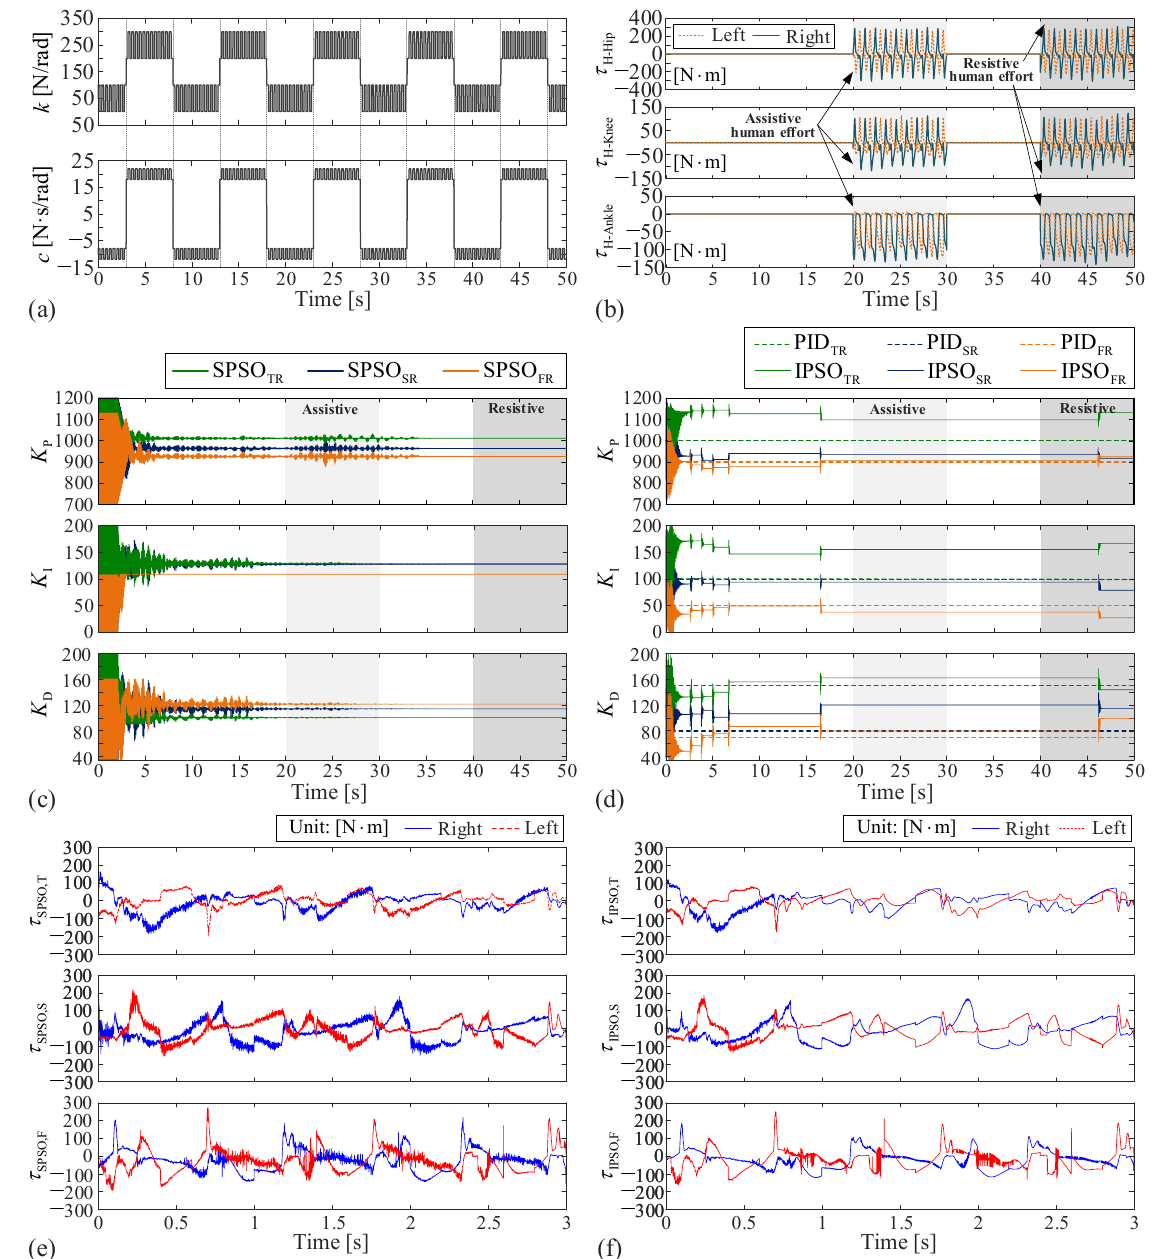
Figure 3. Tracking results of Case I. ( a ) Fast and slow variations of the stiffness and damping of the exoskeleton joints. ( b ) Positive and negative human effects applied to the exoskeleton. ( c , d ) show evolutions of the PID gains corresponding to the SPSO and the IPSO algorithms, respectively; for reference, the pre-tuned PID gains are also plotted in ( d ). ( e , f ) show the control torques of the exoskeleton joints during 0–3 s corresponding to the SPSO and the IPSO algorithms, respectively. K is not allowed to take values lower than 35 to prevent possible insta ‐ Here, Unless otherwise stated, this assumption applies to all four cases to demonstrate the D_PSO capability of the proposed controller in coping with non-negligible parameter bility. For the hip joints, the derivative gain is adjusted into the following: